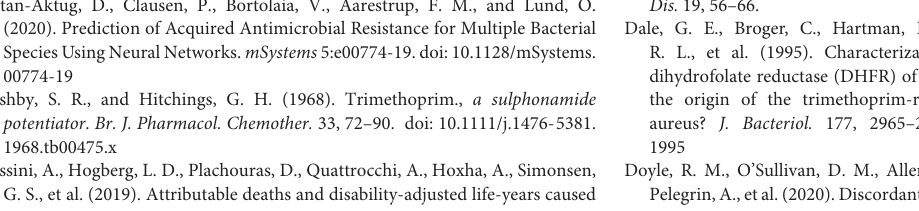
Supplementary Figure 1 | Amino acid sequence of a truncated DHFR dfrG (D1876) due to a nucleotide deletion at position 381 of the dfrG resulting in a trimethoprim susceptible phenotype. Supplementary Figure 2 | Minimum spanning tree (MST) of our study cohort. The MST is calculated using all 67571 polymorphic sites across the core-genome and with the MSTV algorithm from the software GrapeTree Strains are color-coded based either on (A) their MLSTs, (B) their DHPS variants, (C) their dfr genes. The arrows in (B) indicate the two high-level SMZ resistant S. aureus isolates harboring the F17L mutation of the chromosomal